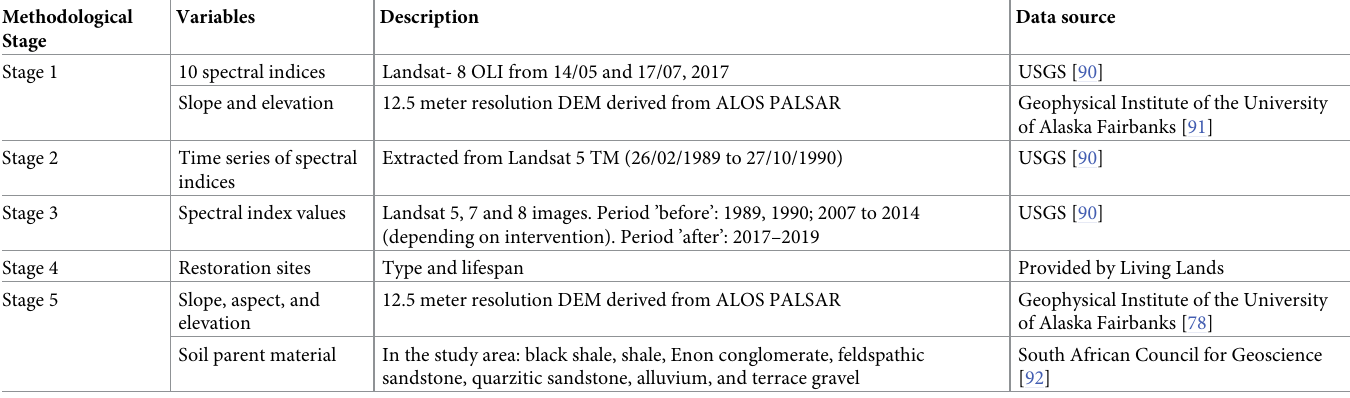
Table 3. Spatial input data for methodological